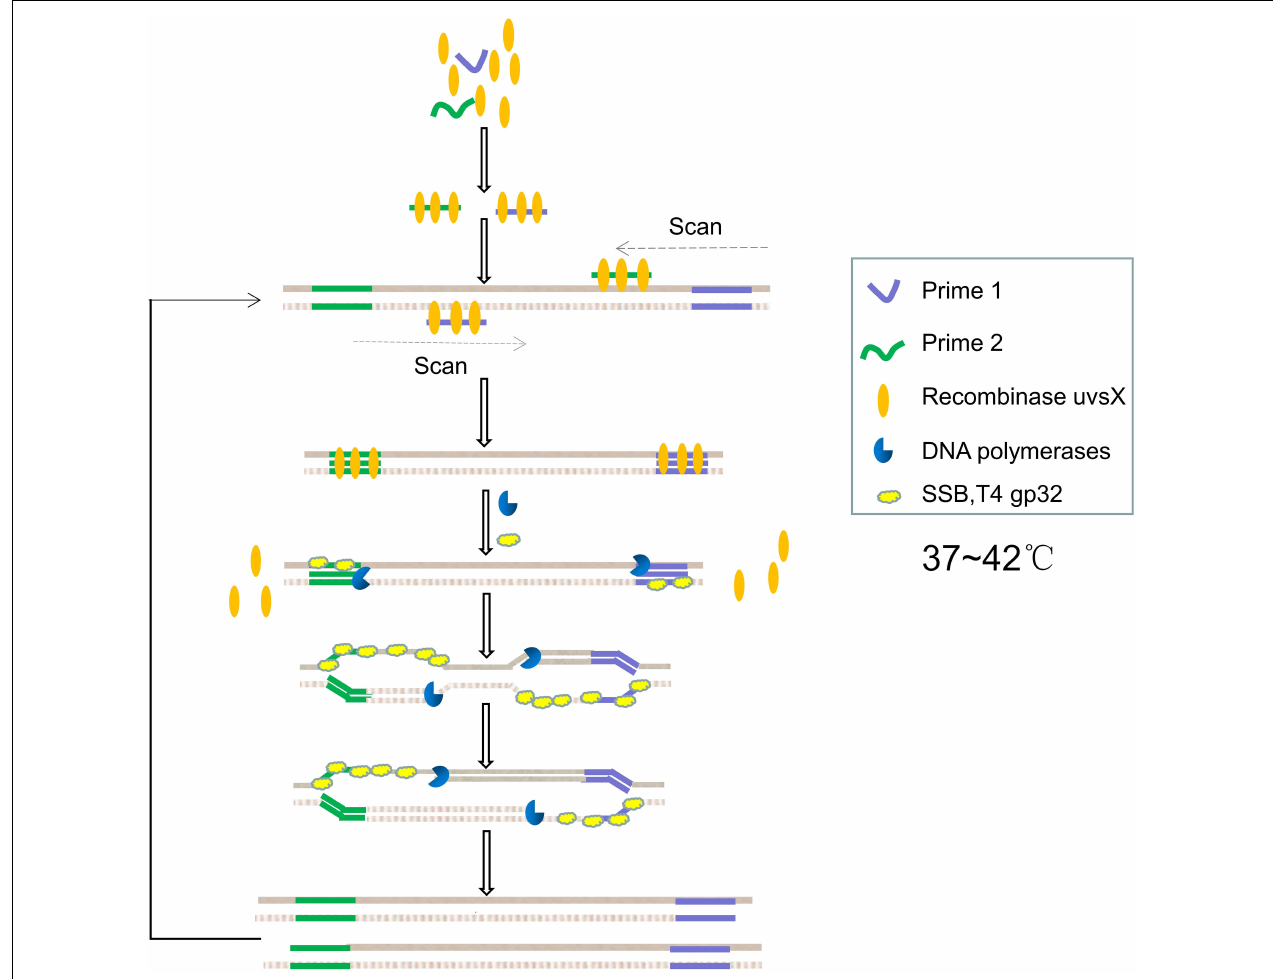
FIGURE 3 | Schematic diagram of recombinant enzyme polymerase